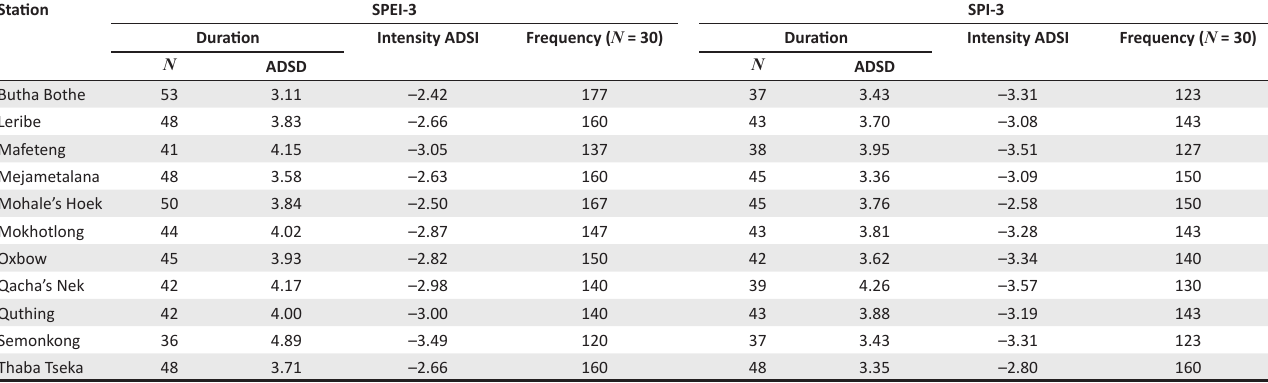
evapotranspiration-3 TABLE 5: Standardised precipitation evapotranspiration and standardised precipitation drought parameters. Station